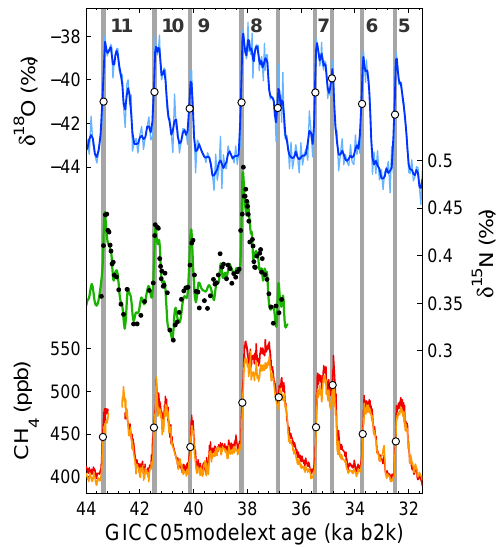
Fig. 7. NEEM data used in 1 age reconstruction at the onset of in- terstadials 8–11. (a) δ 18 O of precipitation as a proxy for site tem- perature with 0.55m averages in light blue, and a 5-point running mean in dark blue; (b) δ 15 N of N 2 from Guillevic (2013) (black dots) and model output (green curve); (c) methane data from con- tinuous flow analysis: PICARRO instrument (orange) and SARA instrument (red) (Chappellaz et al.,